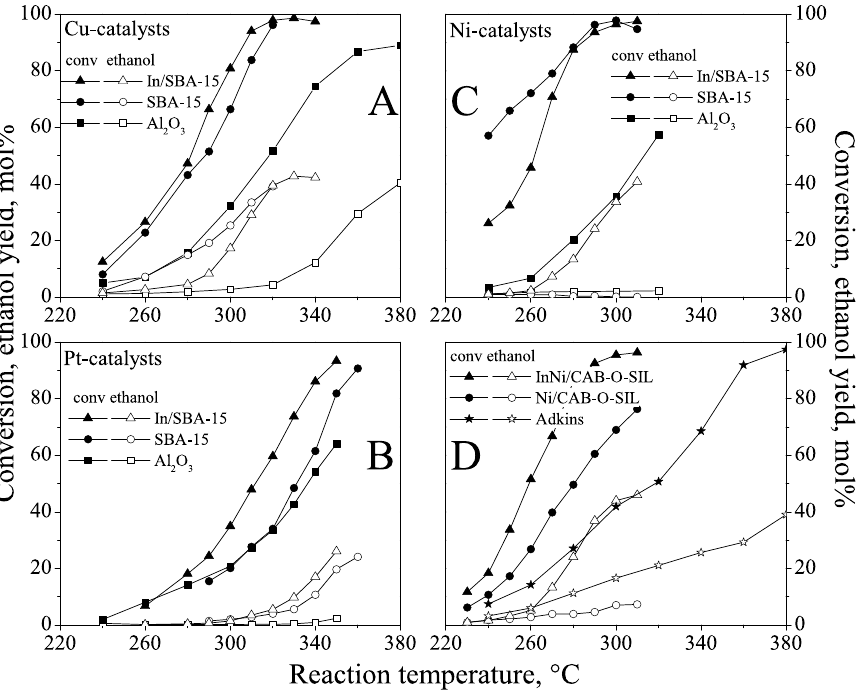
Figure 5 : Comparison of conversion (solid) and ethanol yield (open) curves grouped as Cu-catalysts (A), Pt-catalysts (B), Ni-catalysts (C) and Ni/silica (CAB-O-SIL) together with Adkins catalysts